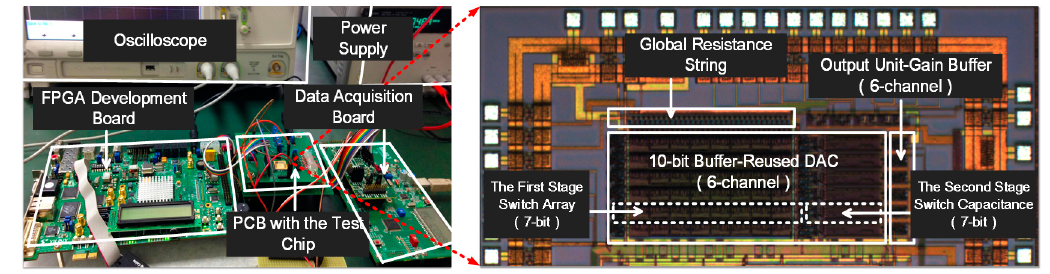
Figure 6. The micrograph of the fabricated chip and the chip test environment.